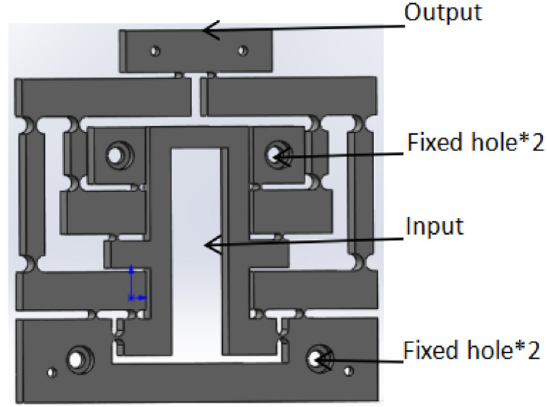
Fig. 4. Design sketch of a displacement ampli fi cation mecha- nism.